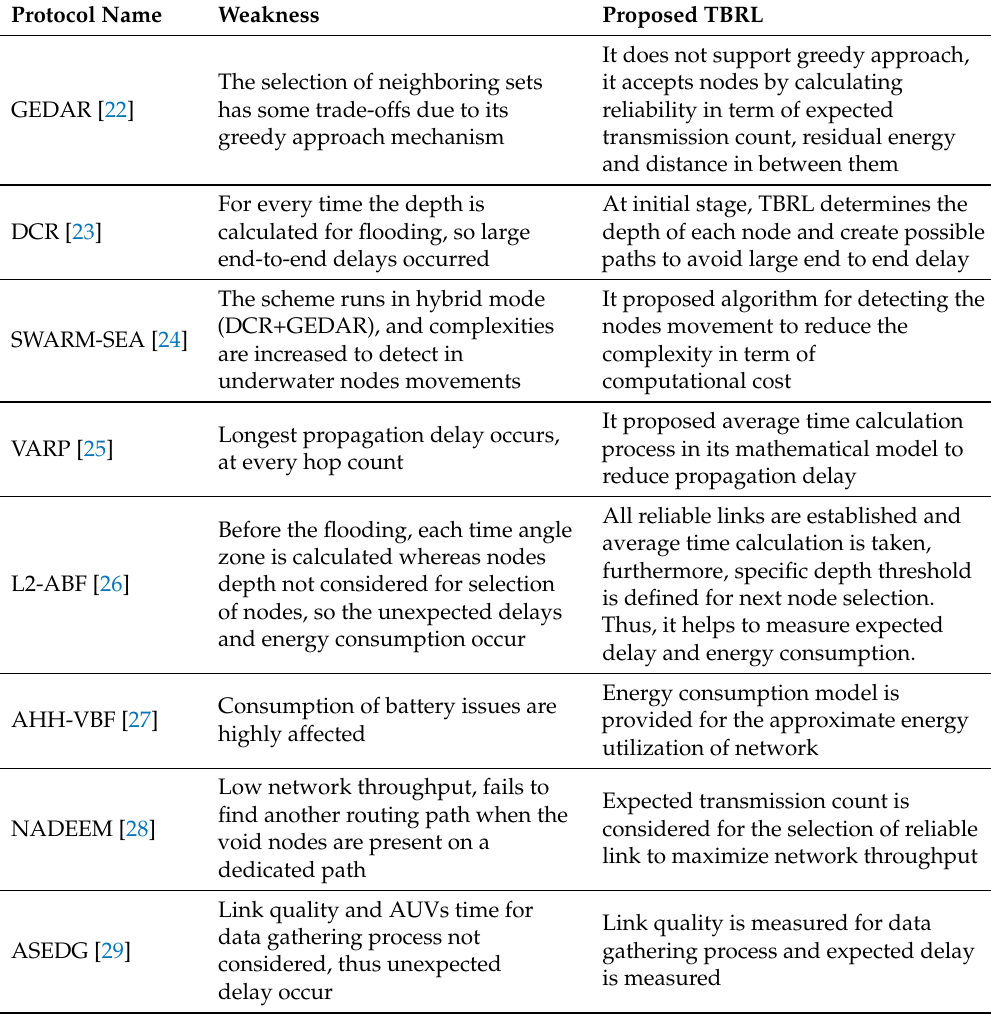
Table 1. Comparison with state of the art routing